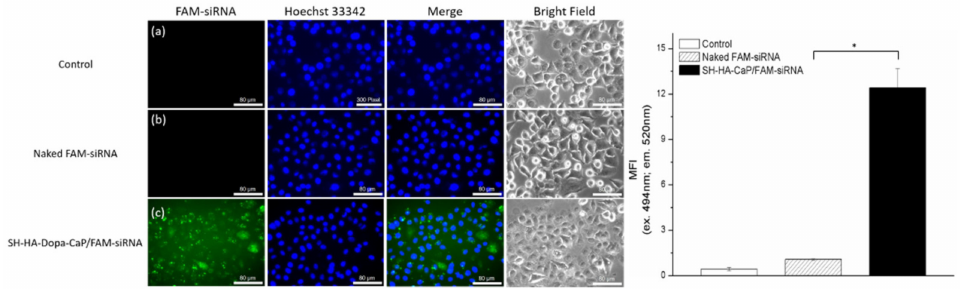
Figure 6. Cellular uptake of ( a ) blank, ( b ) FAM-siRNA, and ( c ) SH-HA-Dopa-CaP/FAM-siRNA (100 nM siRNA/well) after 2 h of incubation with HeLa cells. The data are shown as means ± SD (n = 3); * p <